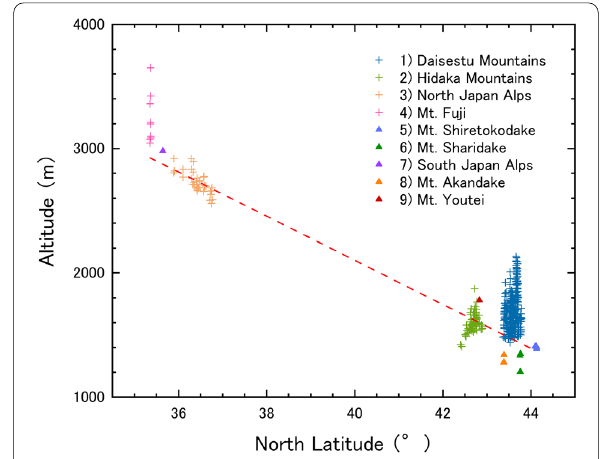
Fig. 3 Latitude–altitude distribution of surface air temperature that maintains permafrost. The colors or shapes of symbols differ for each of the nine regions shown in Fig. 1. The red regression line is calculated using the points that take the lowest altitude at each